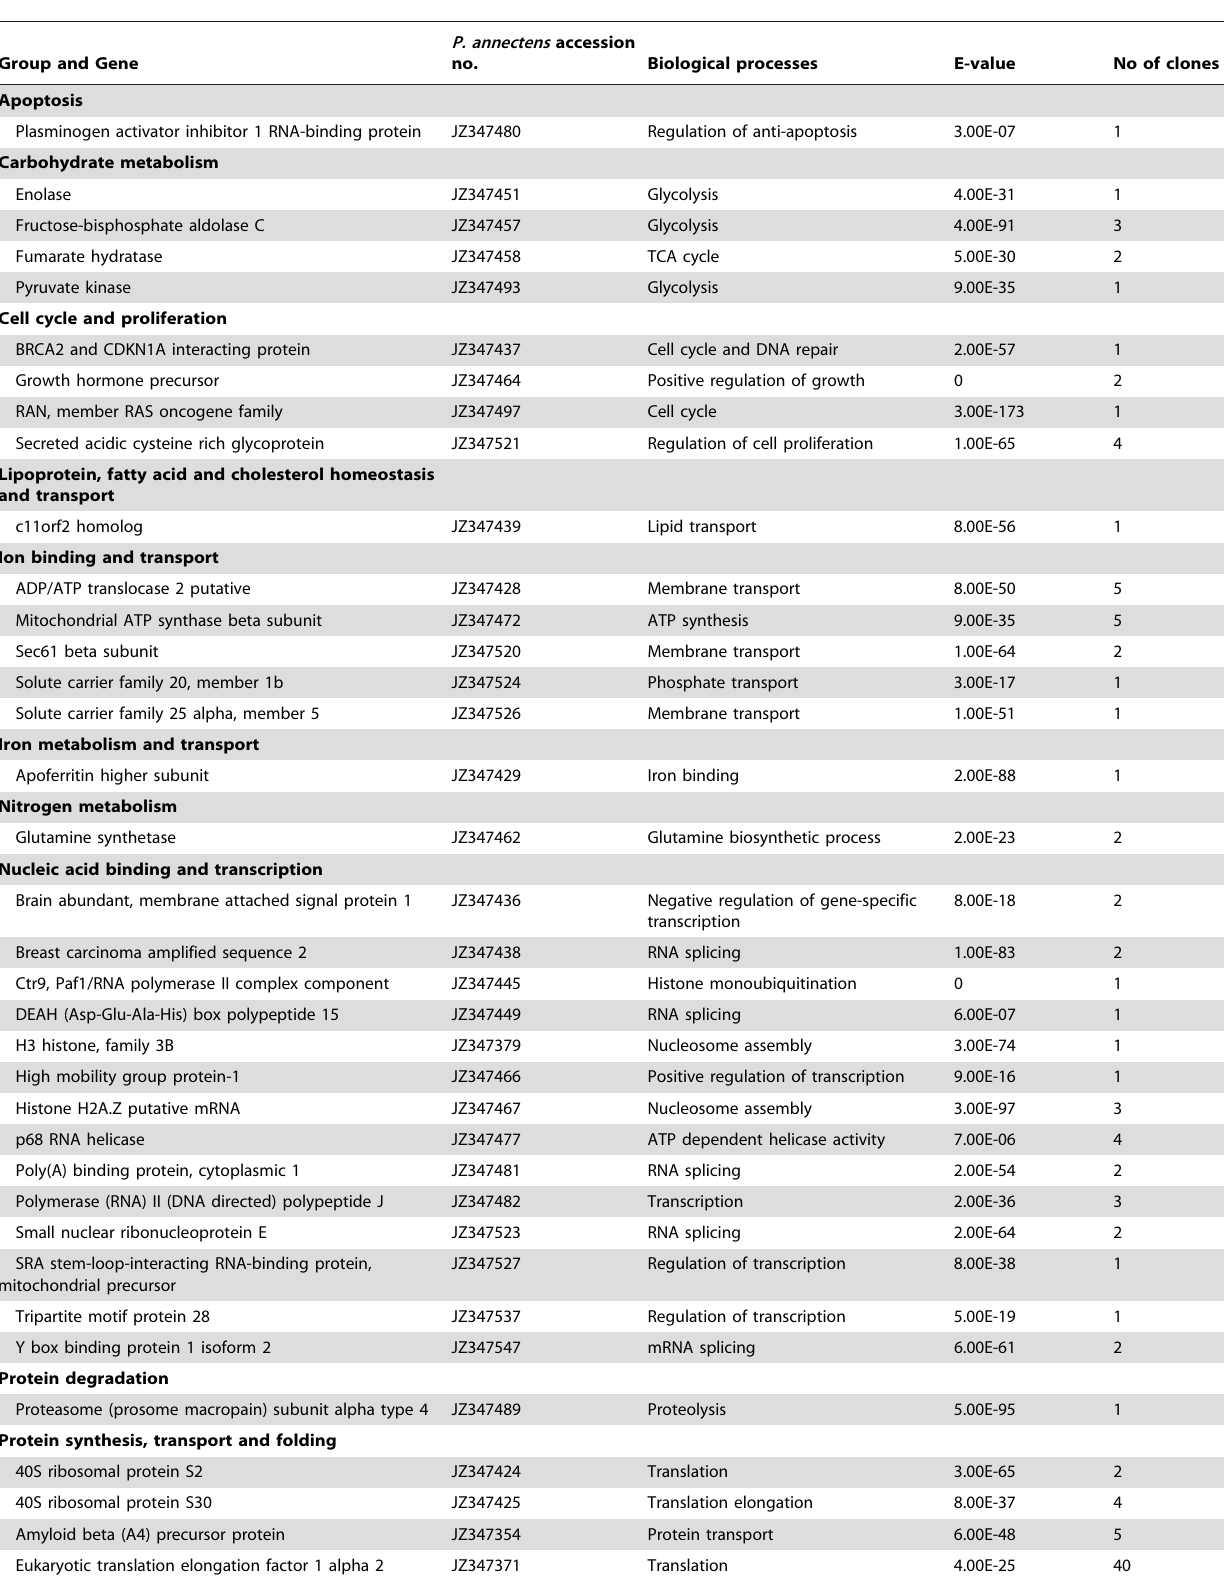
Table 2. Known transcripts found in the forward library (up-regulation) obtained by suppression subtractive hybridization PCR from the brain of Protopterus annectens aestivated for 6 days in air with fish kept in freshwater as the reference for comparison.